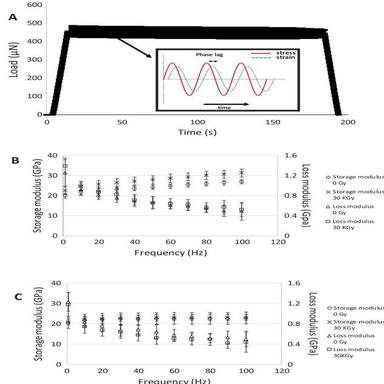
Dynamic indentation tests. An indentation load function was used to assess frequency-dependent storage and loss moduli at each dynamic frequency (A). Storage and loss moduli of the EDJD (B) and PDJD (C) regions with or without x-ray irradiation at each dynamic frequency. Results are expressed as mean ± standard deviation (n.9 on the same sample surface). A p-value of less than 0.05 was considered significant. Six different teeth showed a similar tendency irrespective of the varied moduli related to their st